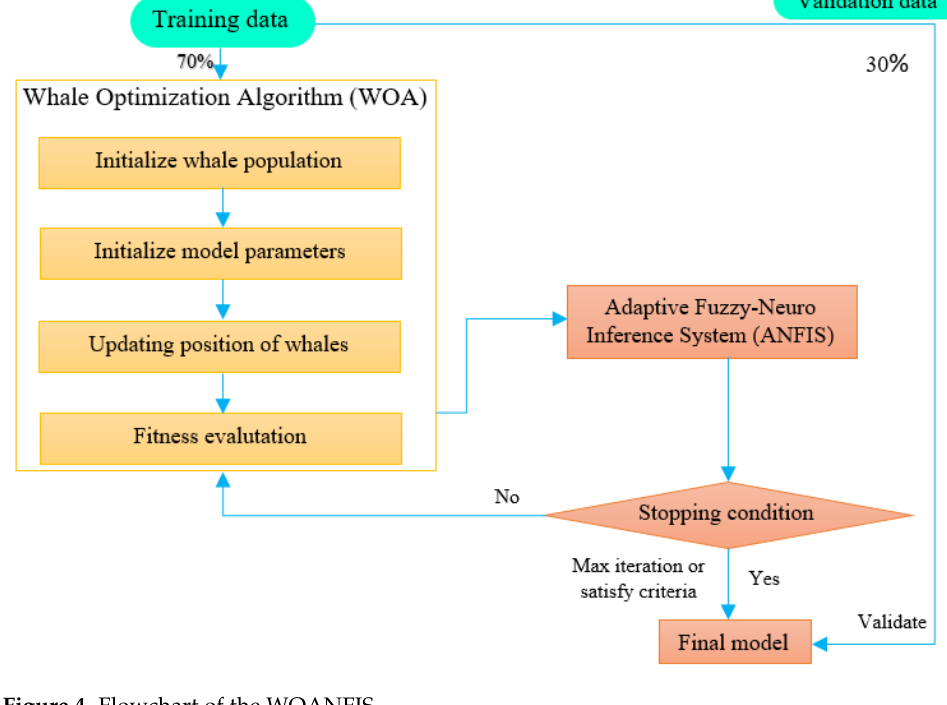
Figure 4. Flowchart of the WOANFIS.